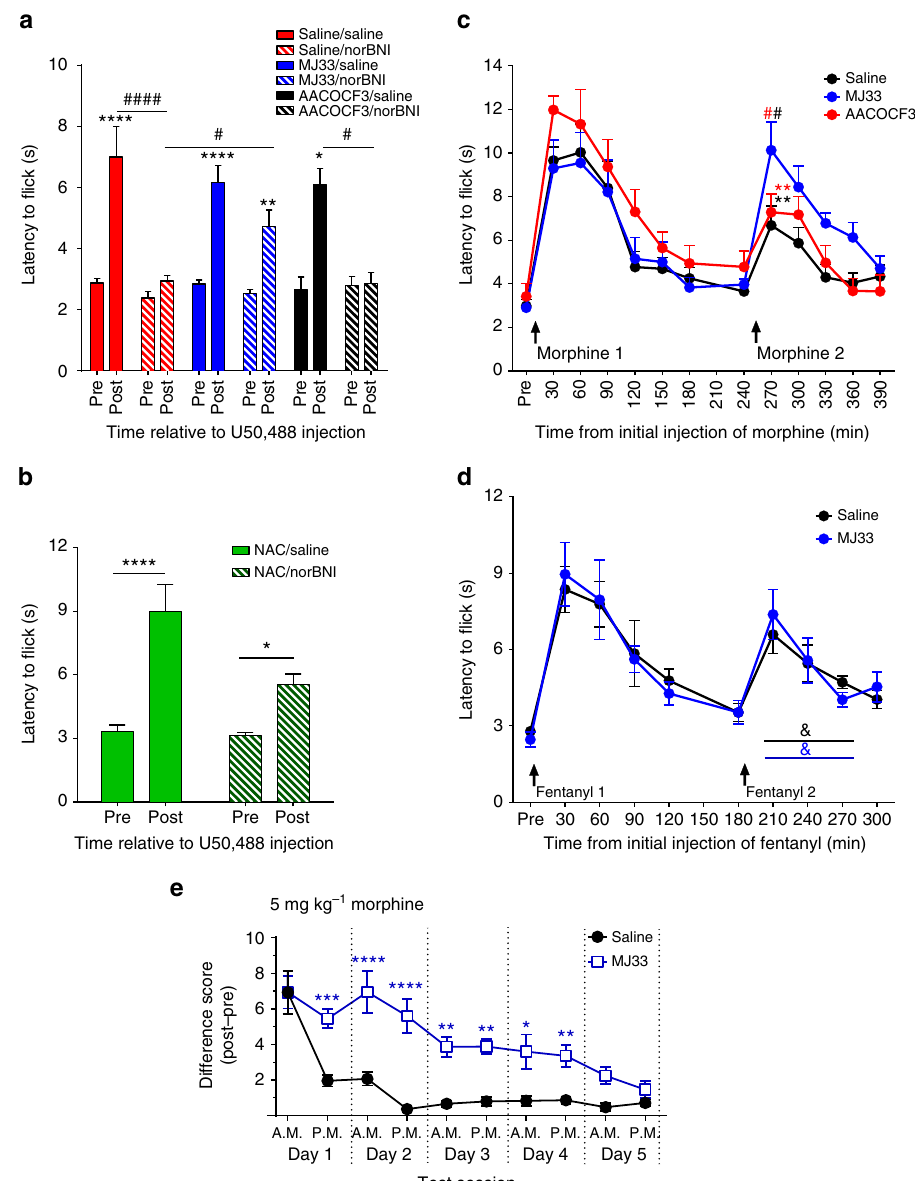
Fig. 4 PRDX6 mediates the long-lasting effects of norBNI and acute morphine tolerance. a , b Mice were injected with saline, MJ33 (1.25 mg kg − 1